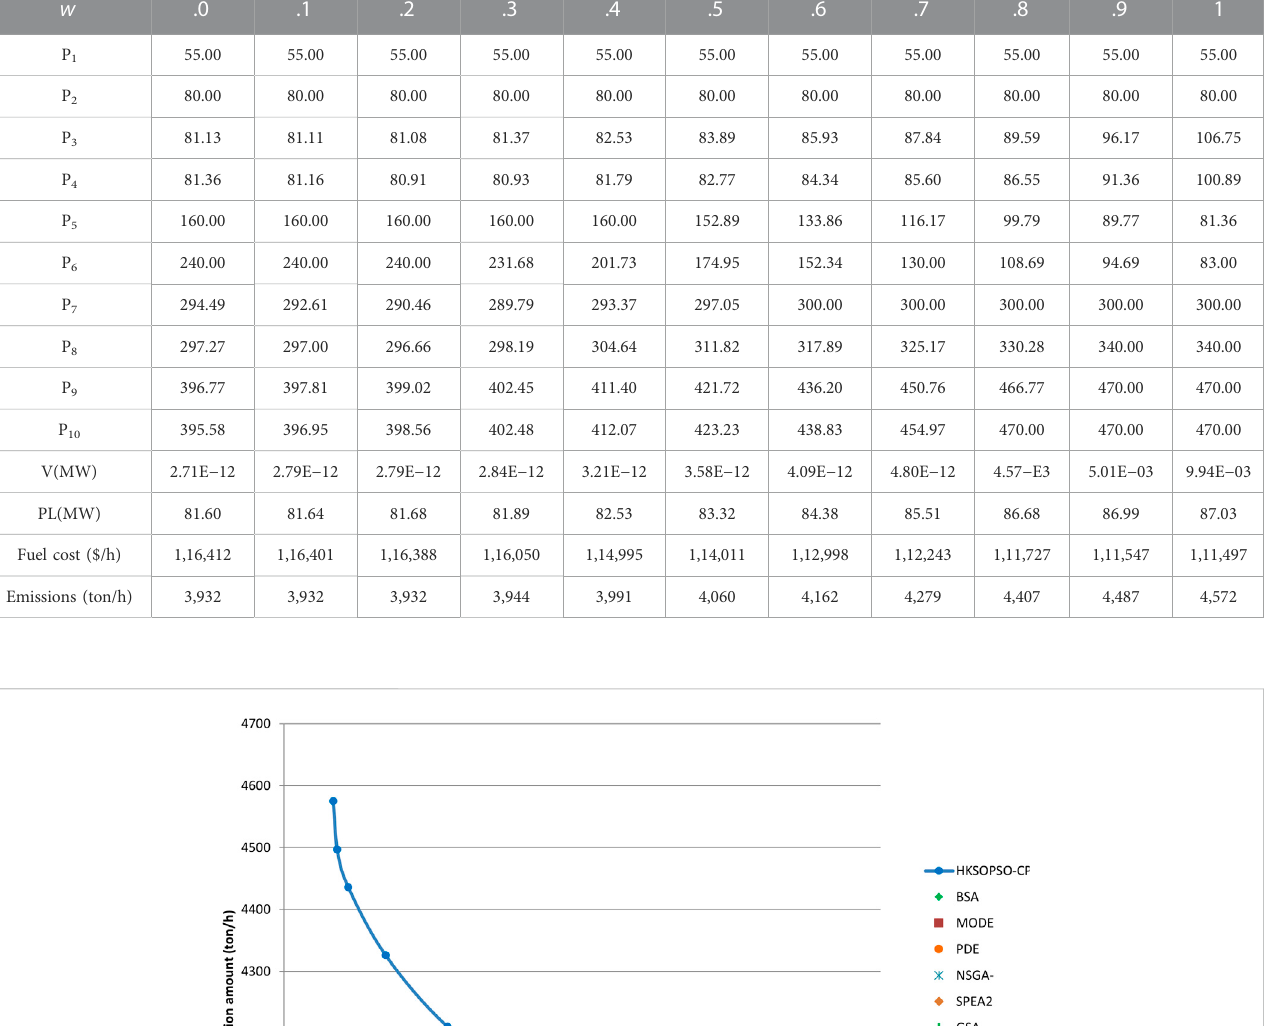
TABLE 7 Best solution values for a 10-unit system with different weights. w .0 .1 .2 .3